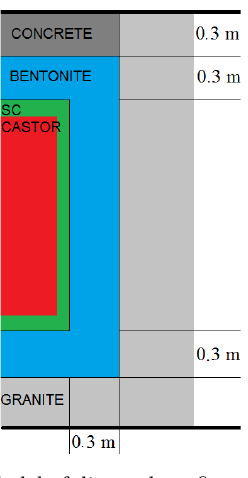
Figure 11. Model of disposal configuration based on the Swedish disposal concept with SC CASTOR hor- izontally disposed. SC is confined by bentonite 0.3 m thick in horizontal position and sealed with concrete. It is fully surrounded by granite.